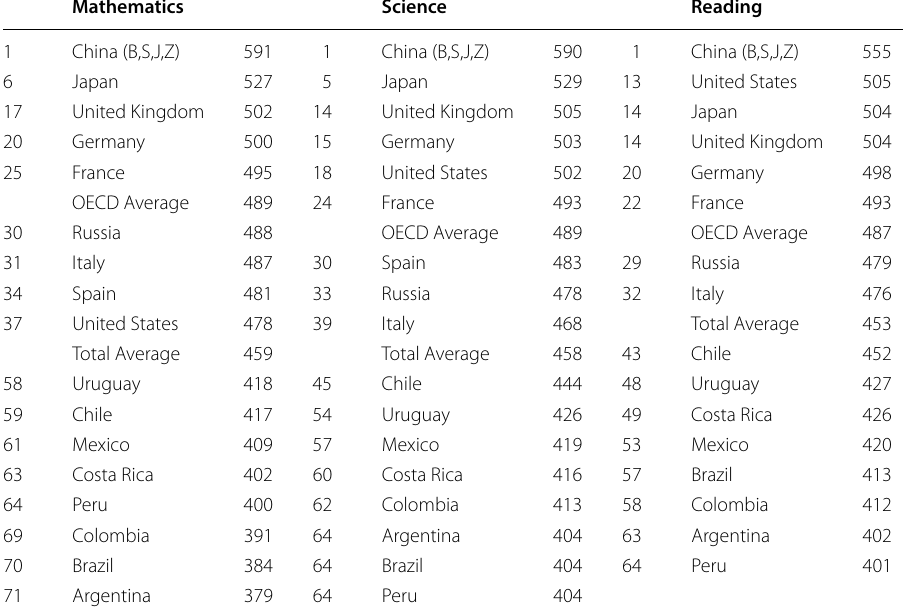
Table 2 PISA 2018 Scores in Mathematics, Science and Reading by selected countries. Source: PISA 2018, OECD